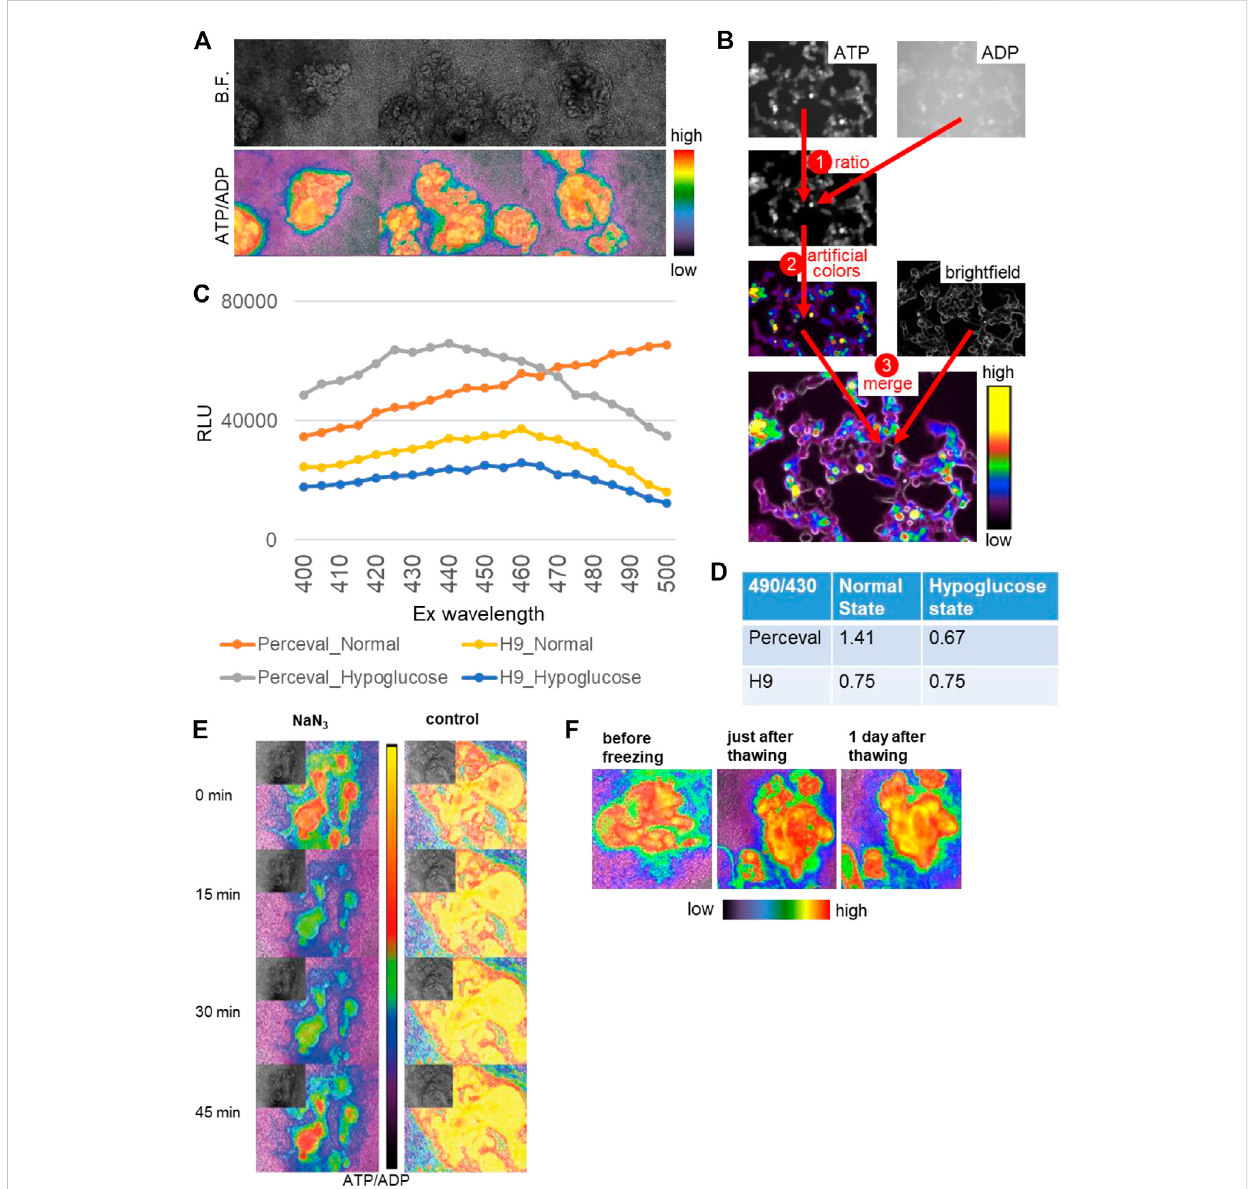
FIGURE 6 Reporter organoids with real-time biosensor Perceval HR to detect ATP/ADP ratio. (A) Bright- fi eld (B.F.) and ATP/ADP ratio (lower) in nephron-like structures of 2D reporter organoids. (B) The channels of ATP (ex495/em540) and ADP (ex436/em540) are used for ratio calculation, transformed in arti fi cial colors, and merged with the bright fi eld. (C) Signal intensities at varied excitation wavelengths from 400 to 500 nm in the parental H9 organoids and Perceval H9 organoids in the normal and hypoglucose culture. (D) The signal ratios of em540 excited by 490 and 430 in the control and hypoglucose organoids, evaluated by a plate reader. The parental H9 was used as a control. (E) The reactivity of ATP/ADP ratio to toxic substance using NaN3. NaN3 was added at 0 min, and the same media were kept in the wells until 45 min. (F) 2D Reporter organoids before freezing, just after thawing, and 1 day after